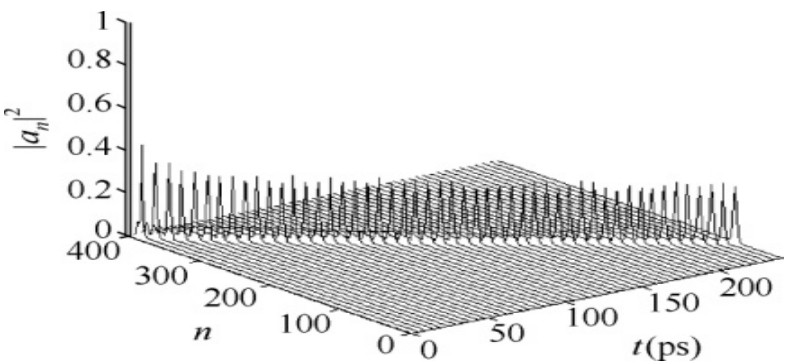
Figure 2. State of the new soliton in the case of a longtime period of 250 ps and long spacing of 400 amino acid residues.